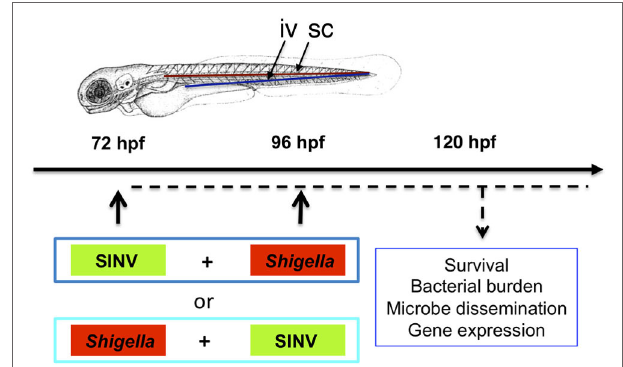
FigUre 1 | Modeling viral-bacterial co-infection in zebrafish. Scheme of the experimental set up of viral bacterial co-infection using zebrafish. A 72 hpf zebrafish larva is shown. Microbes are injected in the bloodstream [intravenously (iv)] via the dorsal aorta (red line) or the ventral vein (blue line). Subcutaneous injections of the bacteria (sc) are performed over a somite, in the caudal region of the larva. Sindbis virus (SINV) and Shigella flexneri bacteria ( Shigella ) are sequentially injected in the bloodstream (iv) of zebrafish larvae at 72 and 96 hpf. Both SINV + Shigella and Shigella + SINV sequential co-infections are tested. Non-injected fish and fish injected with SINV or Shigella alone are used as a control. Single SINV or Shigella injections are performed at 72 or 96 hpf depending on the sequential co-infection tested. Survival, viral replication, bacterial burden, neutrophil behavior and expression of antiviral and antibacterial related genes are monitored over time as represented (dotted black